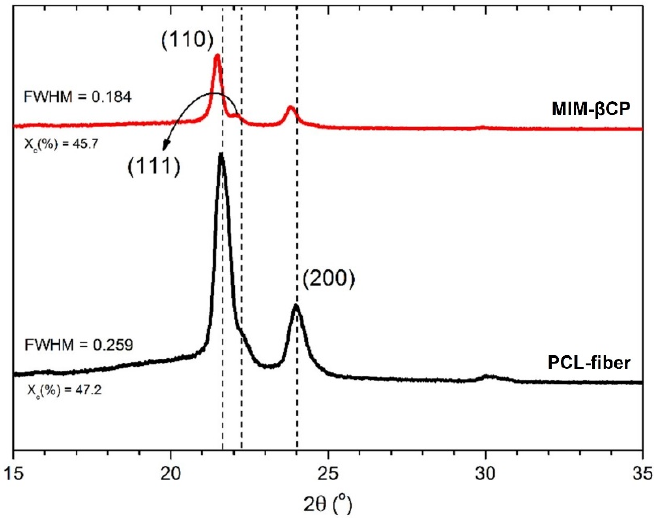
Figure 6. XRD patterns of PCL–fiber (black line) and MIM– β CP (red line).